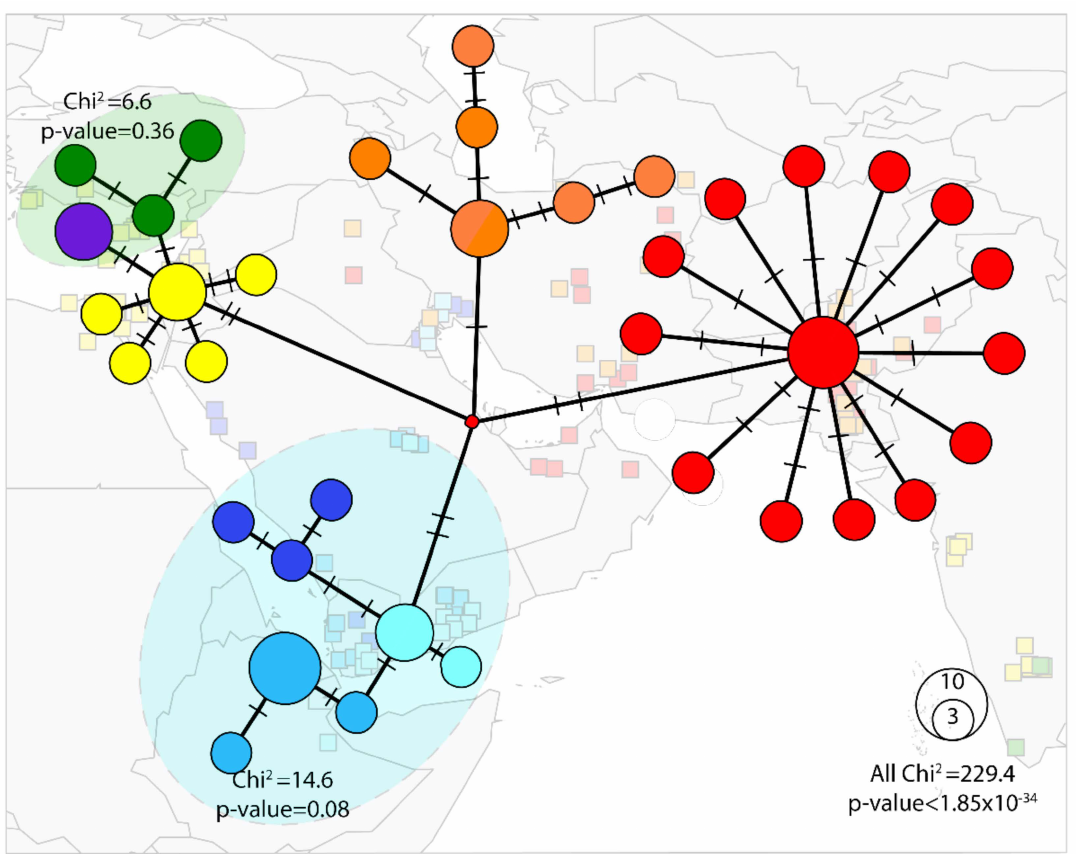
Figure 3. Median joining network of the Bemisia tabaci B mitotype ( ε = 0). The blue shading indicates POP1, the single population comprising haplotypes NAFME 1–3. The orange-colored circles represent POP2 constituted by NAFME 4. The red circles indicate POP3 formed by haplotype NAFME 5. Green circles demarcate haplotype NAFME 6, the purple circle indicates haplotype NAFME 7, which together form population POP4. Yellow circles denote haplotype NAFME 8, which alone constitute population POP5. Relative abundance is represented by the size of each circle. Black lines show the relatedness between haplotypes, and lines shown on branches indicate the number of